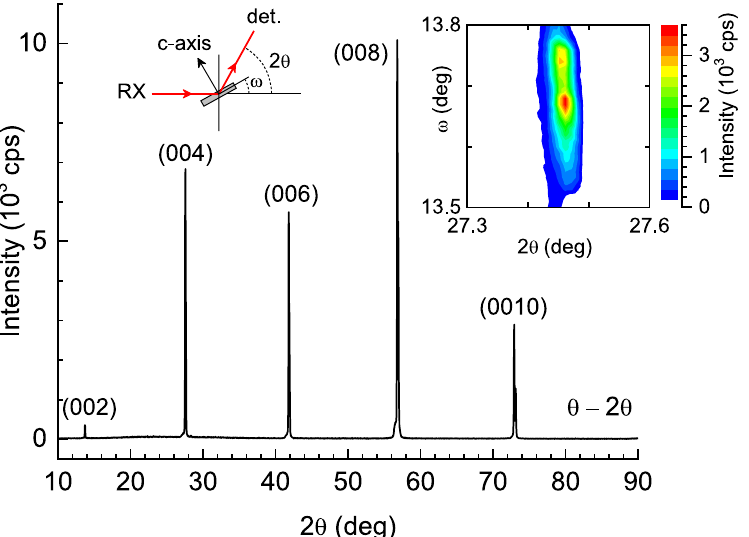
Figure 7. X-ray diffraction pattern obtained with the geometry indicated in the diagram. Only the (00 l ) reflections are observed. Inset: ω − 2 θ intensity map for the (004) peak, showing that the dispersion in the orientation of the crystal c axis is about 0.2 ◦